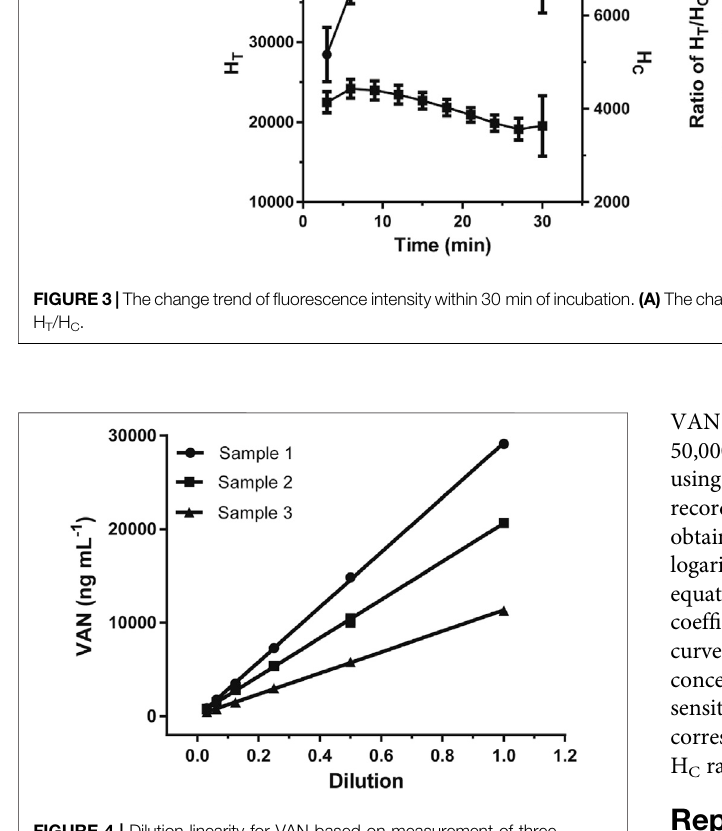
FIGURE 4 | Dilution linearity for VAN based on measurement of three serum